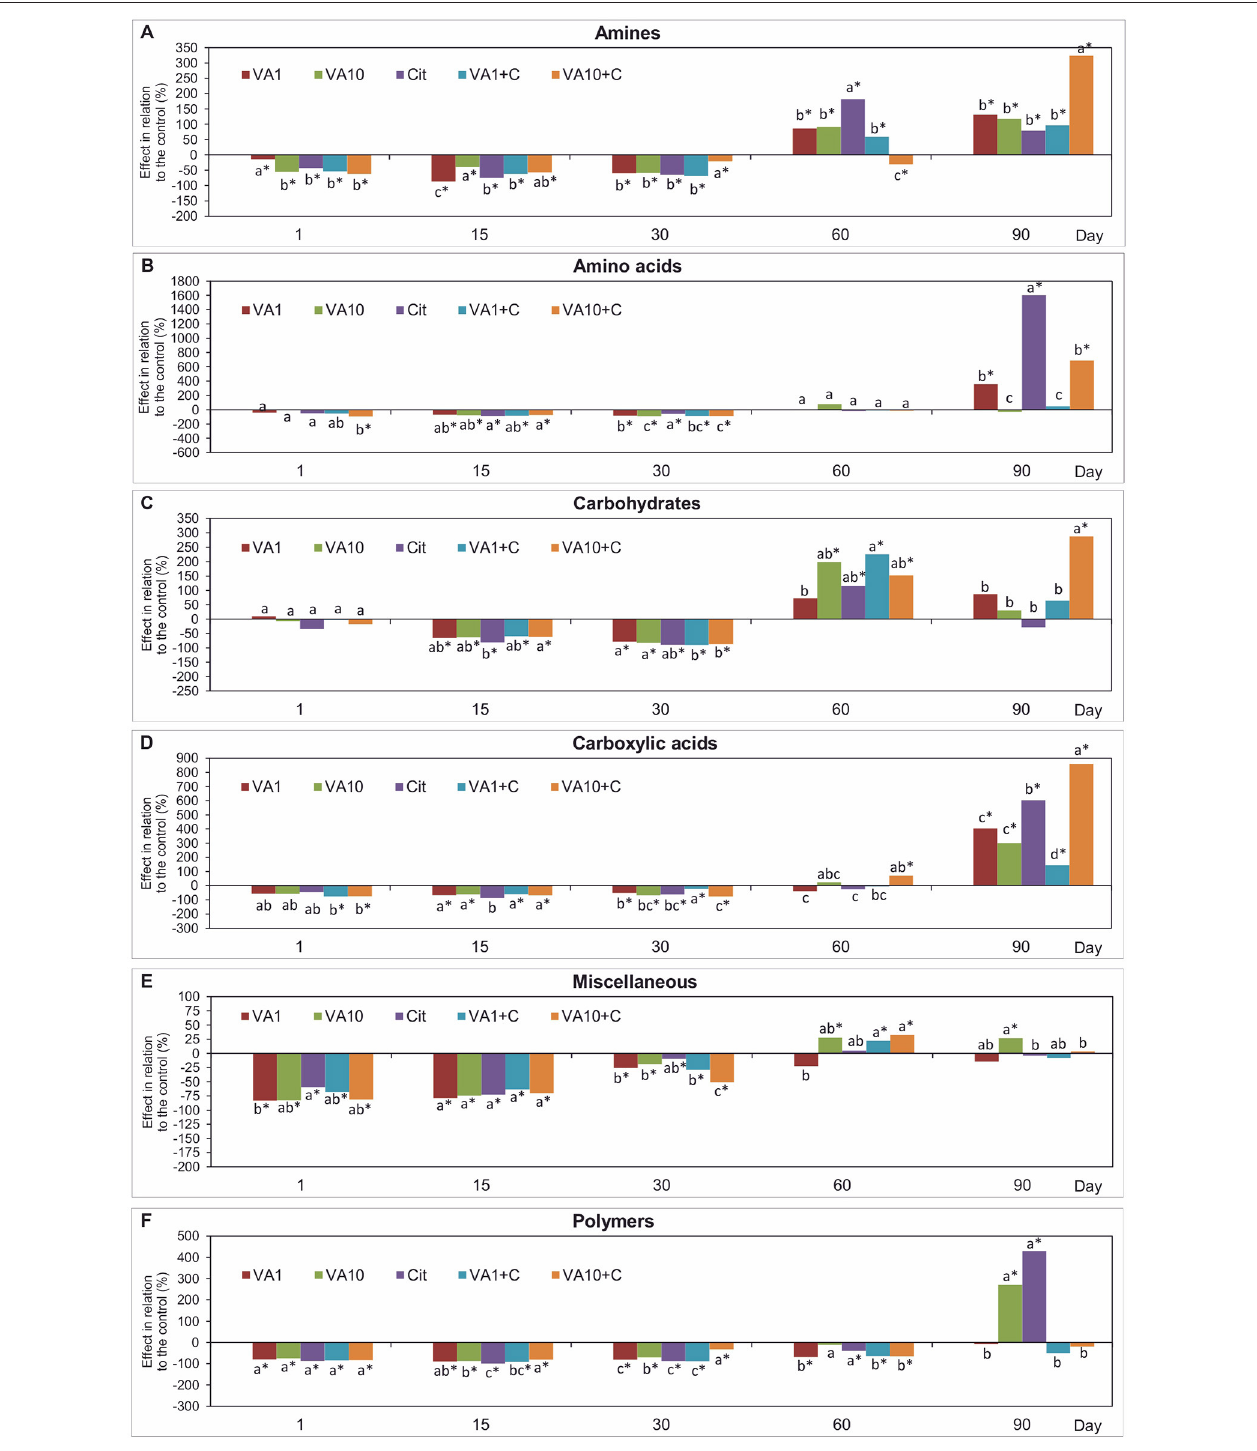
FIGURE 3 | Effect of VA and/or C . freundii on the AWCD of the carbon substrate groups: amines (A) , amino acids (B) , carbohydrates (C) , carboxylic acids (D) , miscellaneous (E) , and polymers (F) during the experimental period. The data are the means ( n = 3) and expressed as a percentage of the inhibition or stimulation in relation to the control soil. Different letters and asterisks within the values of each substrate indicate significant differences between treatments, and between treatments and control at the same sampling time (LSD post hoc test; P < 0.05), respectively. The explanation of the treatment abbreviations is given in Figure 1 .